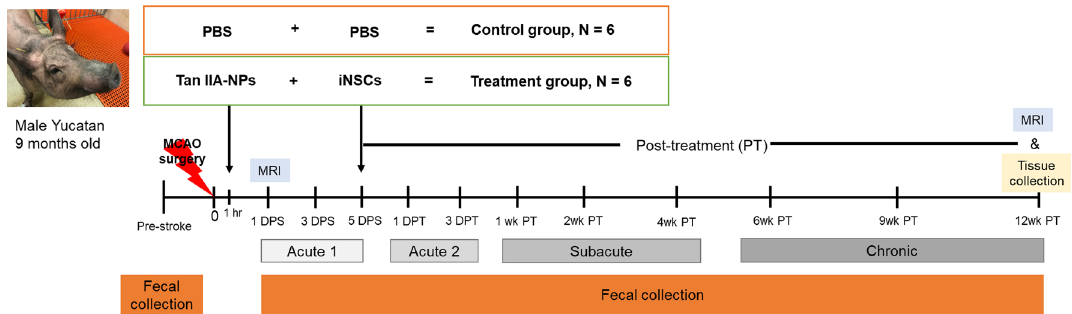
Figure 5. Experimental study design. Castrated male Yucatan pigs (9-month-old, 31–41 kg body weight) underwent middle cerebral artery occlusion (MCAO) and received either PBS (Control group, n = 6) or Tan IIA-NPs and iNSCs (Treatment group, n = 6). Either PBS or Tan IIA-NPs were administered intracisternally at 1 h post-stroke (PS) and PBS or iNSCs were transplanted into the perilesional region at 5 days PS. Ischemic stroke was confirmed at 1 day PS by magnetic resonance imaging (MRI) and lesion volume and midline shift were measured 12 weeks (wk) post-transplantation (PT). PS stages were categorized into Acute 1 (1–5 days PS), Acute 2 (1–3 days PT), Subacute (1–4 week PT), and Chronic (6–12 week PT) 57,58 . Fecal samples were